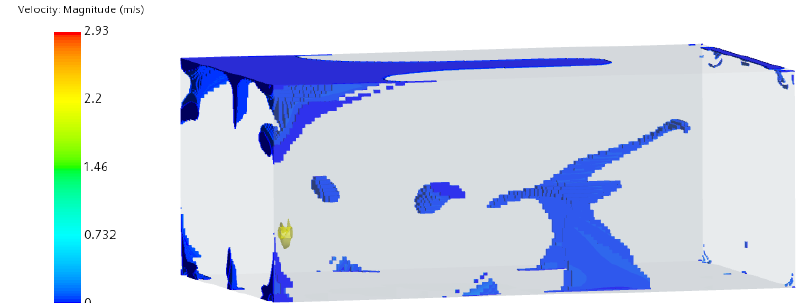
Figure 15. Thermal map of particles distribution in a10.